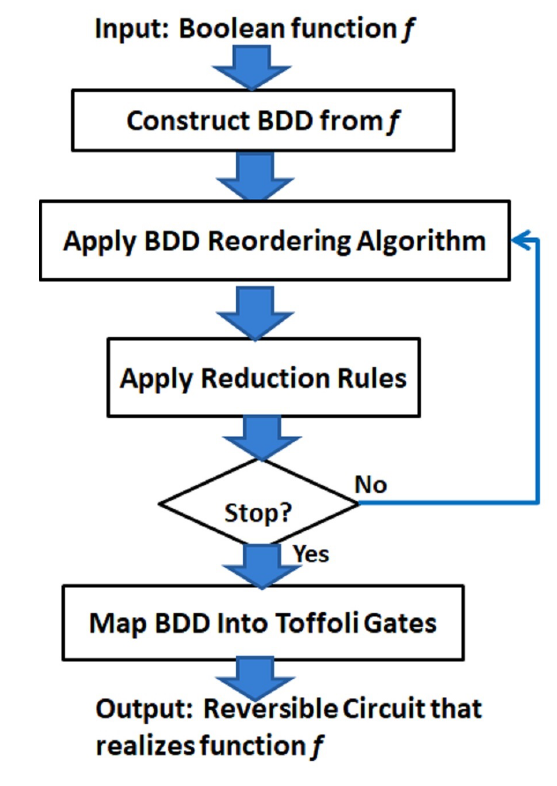
Figure 4. BDD-based synthesis for reversible circuits following the algorithm published in [27]. Table 2. One-to-one mapping from BDD nodes to cascades of reversible gates. Node Circuit Node